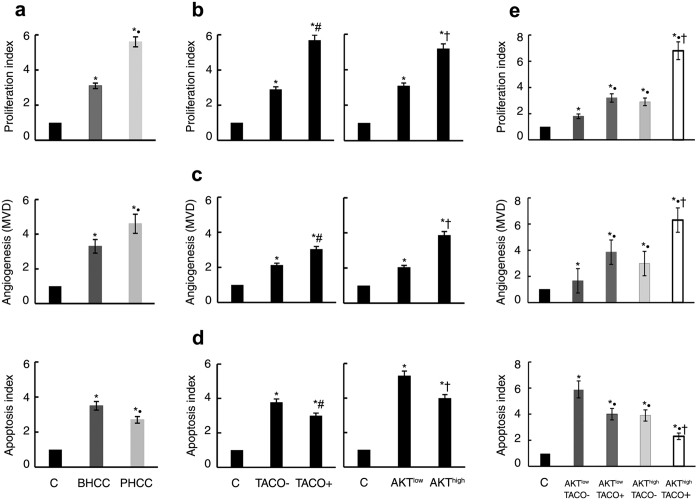
Associations of AKT levels and TACO expression with cell proliferation, apoptosis and the angiogenesis index in human HCC.(a) Proliferation, angiogenesis, and apoptosis indices in HCC subgroups. Bars indicate values relative to paracancerous tissues. The data represent the mean ± SD of 56 patients in the BHCC group and 58 patients in the PHCC group. *P < 0.05 compared with control, •P < 0.05: PHCC vs. BHCC. Indices of proliferation (b), MVD (c), and apoptosis (d) in HCCs harbouring CP WT HBV or TACO mutant HBV (left) and in HCCs expressing different levels of pAKT (right). *P < 0.05 compared with control; #P < 0.05: HCC with TACO+ vs. HCC with TACO−; †P < 0.05: HCC with AKThigh vs. HCC with AKTlow. (e) Above indices for AKThigh and TACO+ combined expression. *P < 0.05 compared with control; •P < 0.05: HCC with AKTlow/TACO+ or AKThigh/TACO− or AKThigh/TACO+ vs AKTlow/TACO−; †P < 0.05: HCC with AKThigh/TACO+ vs. AKTlow/TACO+ or AKThigh/TACO− or AKTlow/TACO−. All controls were normalized as 1.